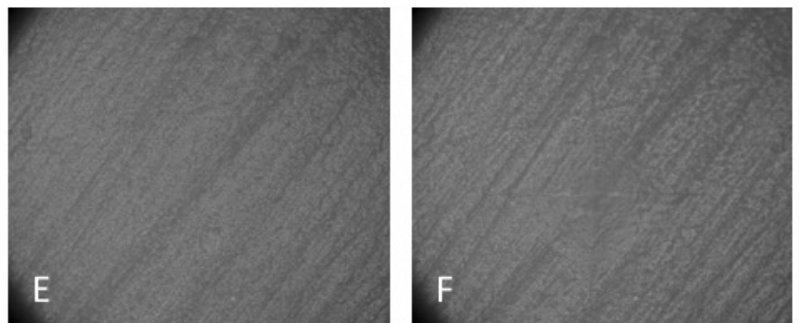
Figure 4. Photomicrographs of nanohybrid composite (Grandio blocs) before and after immersion in acidic drink for 7 and 28 days (40× magnification). ( A , B ) Before immersion; ( C , D ) after immersion in acidic drink for 7 days, ( E , F ) after immersion in acidic drink for 28 days.